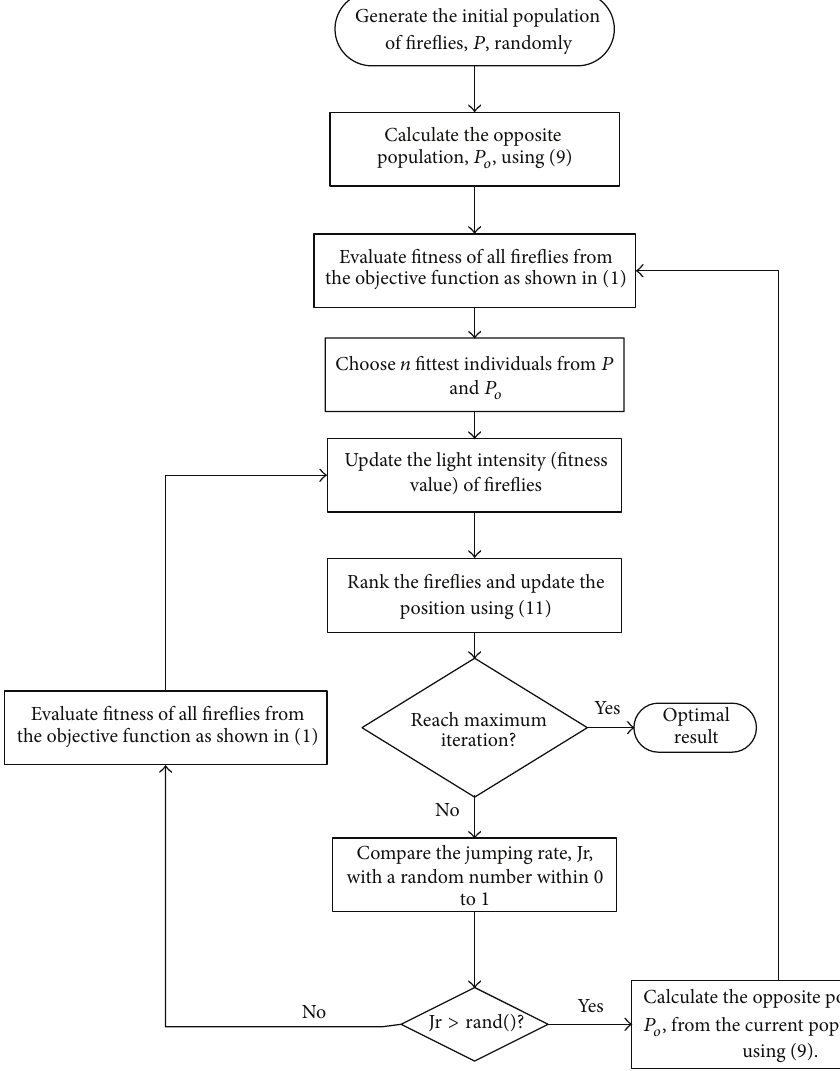
Figure 2: Flowchart for